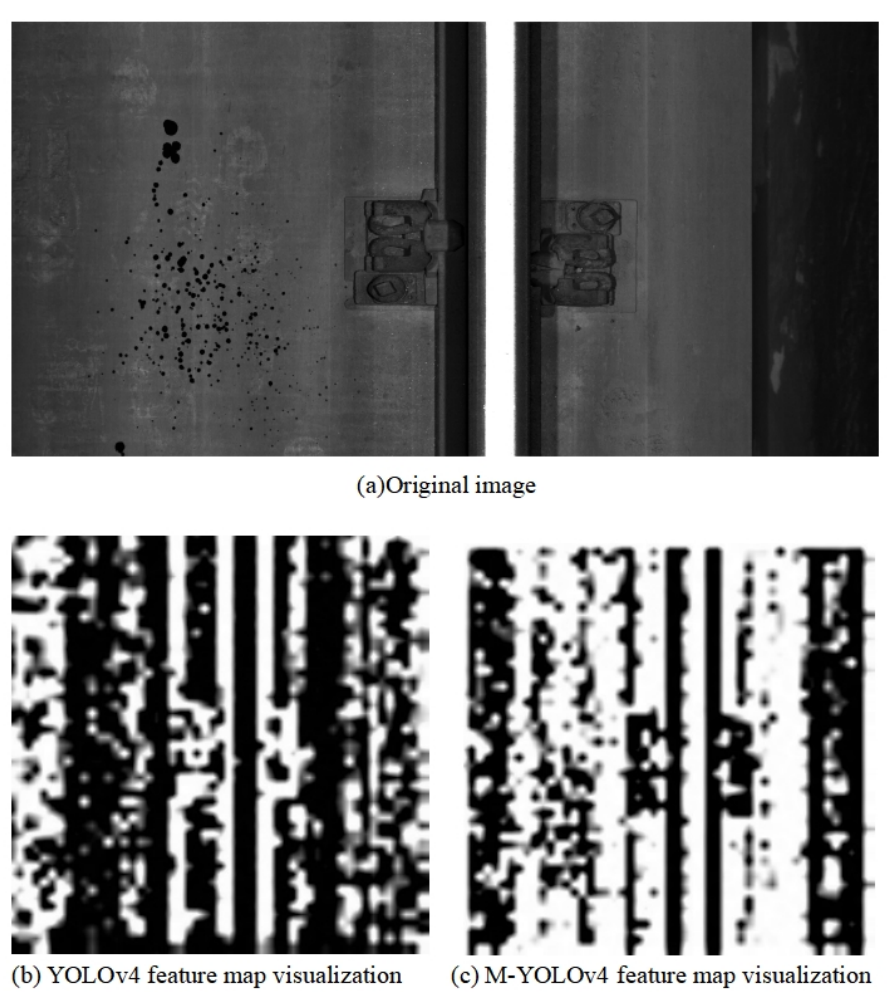
Figure 5. Feature map visualization.